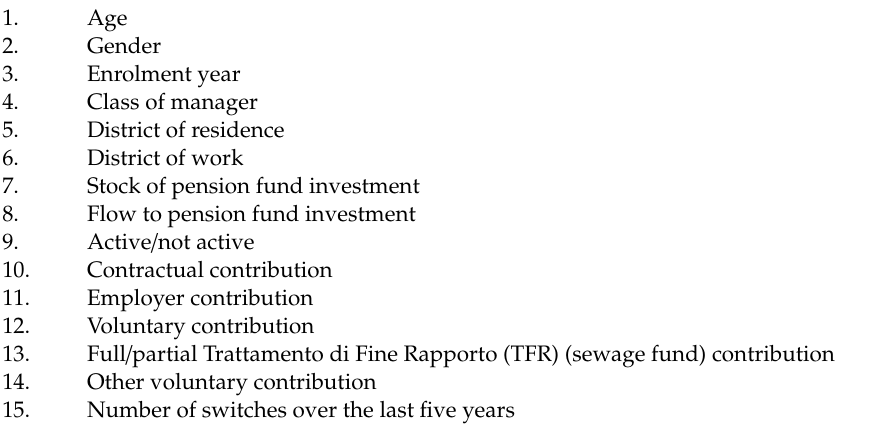
Table A1. Socio-demographic and behavioral variables of the sample.